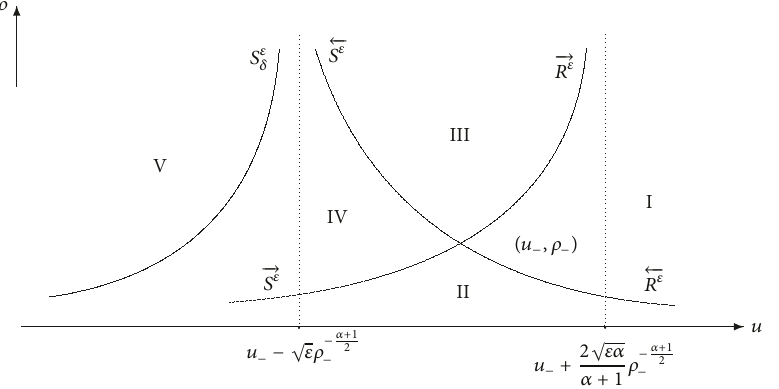
Figure 1: The phase plane ( 𝑢, 𝜌